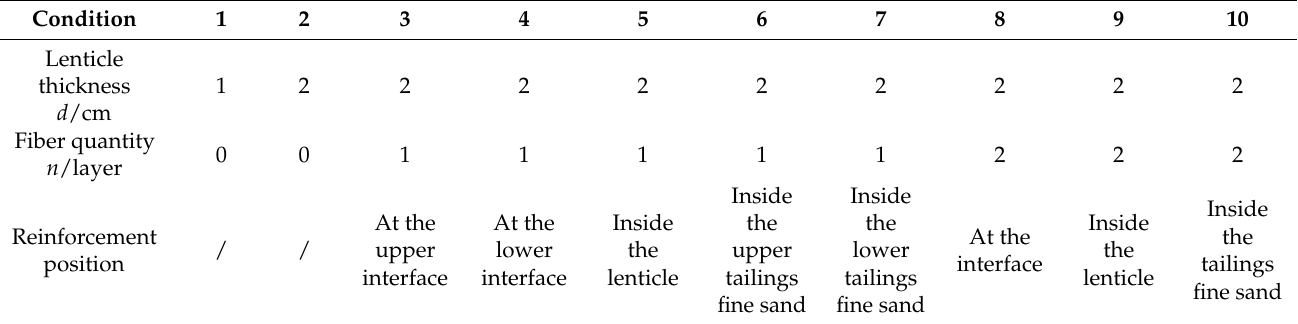
Table 3. The experiment